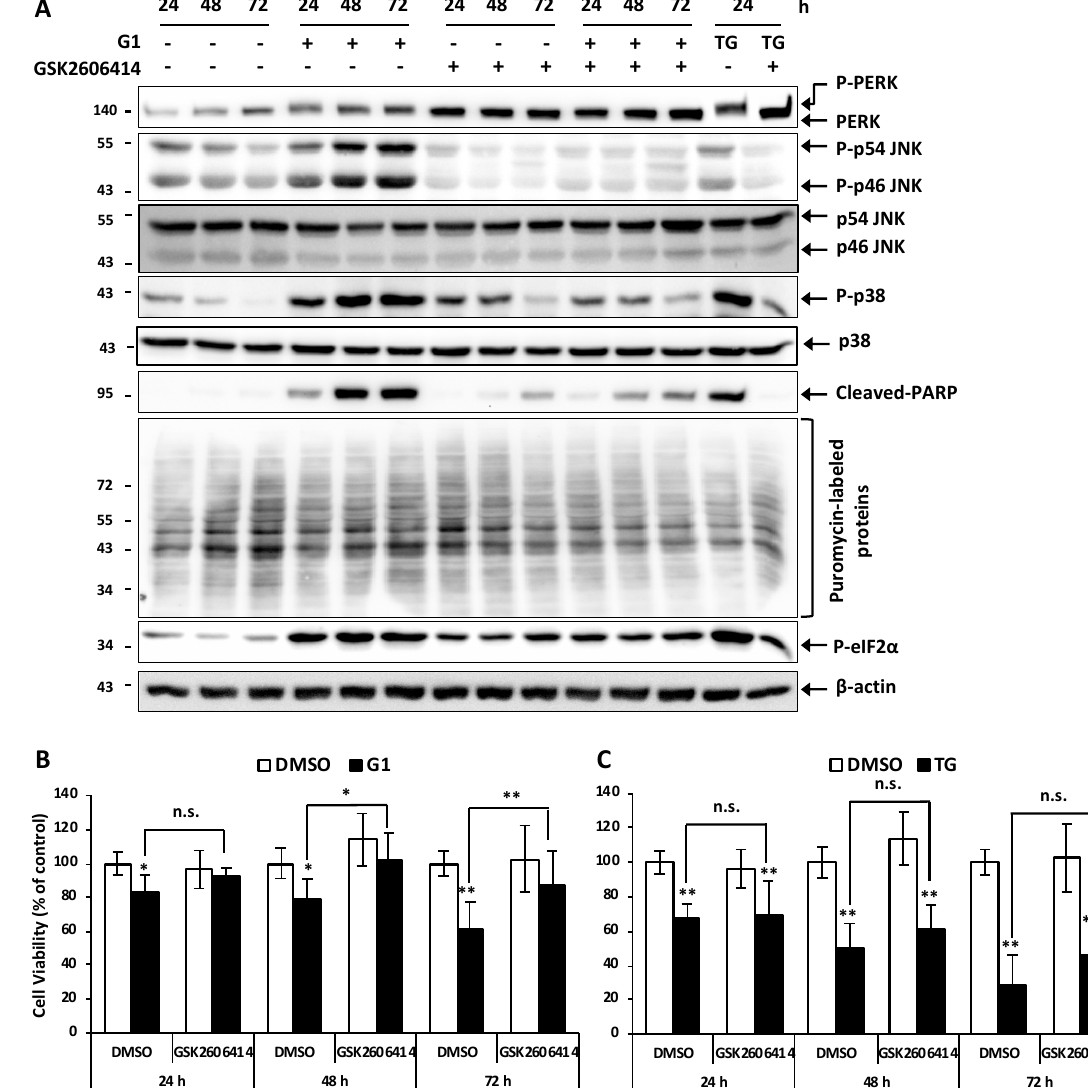
Figure 5. Inhibition of PERK inhibited the activation of JNK and prevented G1-induced cell death in MCF-7 cells. MCF-7 cells were pretreated with 5 µ M GSK2606414, an inhibitor of PERK kinase for 1 h and then exposed to 1 µ M G1 or TG for 24, 48 and 72 h. ( A ) Total protein lysates were subjected to Western blotting using appropriate antibodies as indicated. ( B , C ) Cell viability was measured by the resazurin assay. * p < 0.05, and ** p < 0.01 when compared with cells treated with vehicle or among G1-treated groups. + is indicated for the presence of a treatment meanwhile – is indicated for the absence of a treatment.